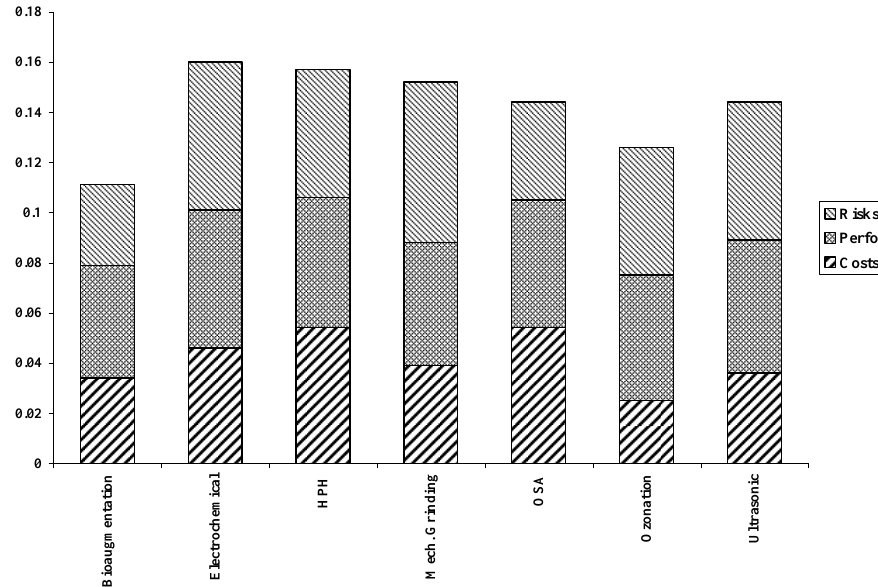
Figure 5. Comparative results of sludge minimization technologies